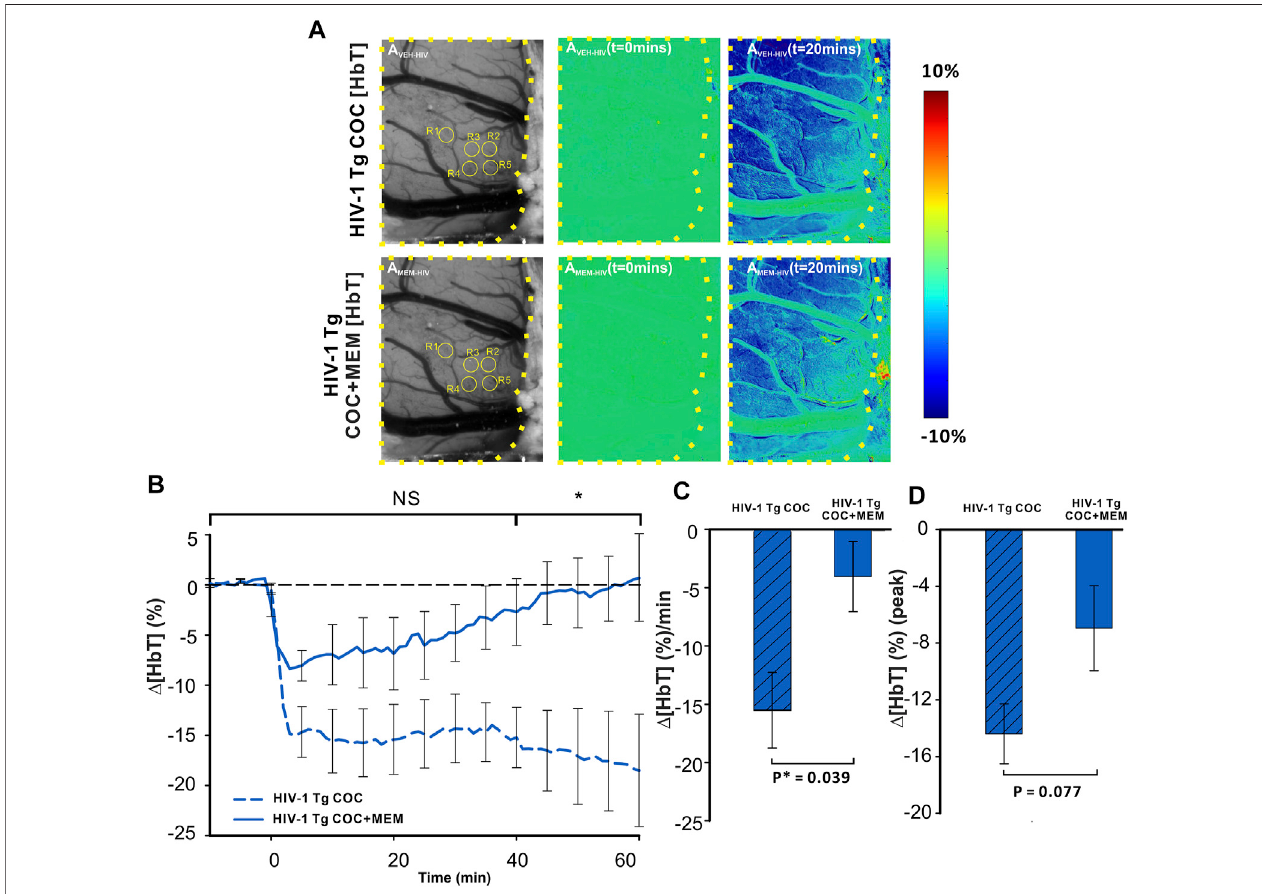
FIGURE 7 | Memantine improves cocaine-induced decrease in Δ [HbT] in HIV-1 Tg rats. (A) Spatiotemporal changes of Δ [HbT] in the PFC of HIV-1 Tg rats in response to cocaine with either pretreatment with vehicle (upper panel) or with memantine (lower panel). (B) Time course of Δ [HbT] response to cocaine in PFC, illustratingthatHIV-1Tgratspretreatedwithmemantinereturnedtobaselinewithin60 minbutnotwithvehiclepretreatment. (C) Memantineattenuatedcocaine-induced reductions in Δ [HbT] and (D) peak of Δ [HbT] changes. Graphed values represent the mean with standard error. ROIs for quanti fi cation are encircled in yellow. The brain region of interest is encompassed by a yellow dashed line. NS: not signi fi cant. *: p < 0.05, signi fi cant difference.